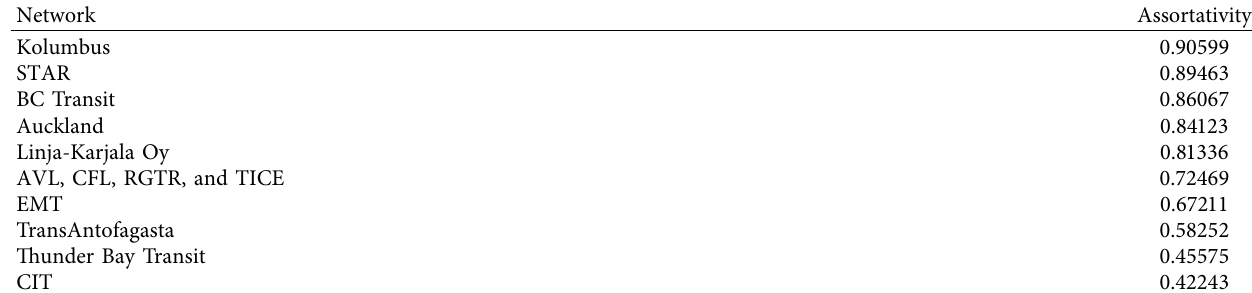
Table 4: Assortativity coefficients in